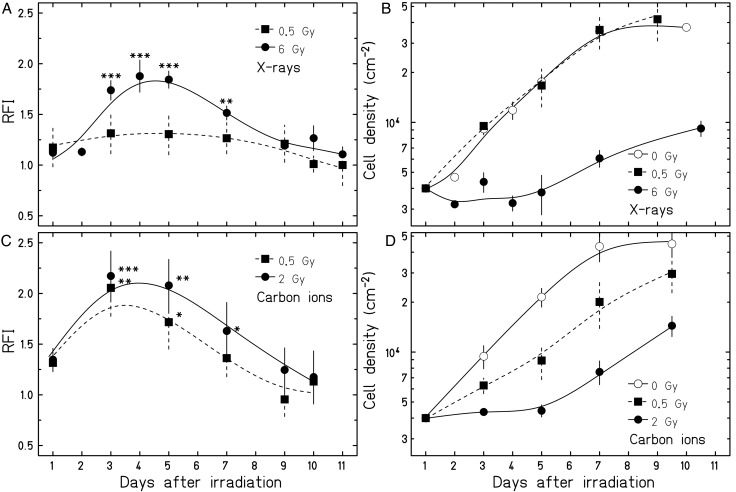
ROS levels and corresponding cell densities of AG1522 cells after X-ray (A, B; n = 3–8) or carbon ion irradiation (C, D; n = 3) as a function of the time after irradiation. Relative fluorescence intensities (RFIs) of DHE normalized to the mean of unirradiated cells (A, C) are shown. In (B) and (D) the corresponding cell densities are depicted. Significant difference of RFI from 0 Gy is indicated by a single asterisk (P < 0.05), two asterisks (P < 0.01) or three asterisks (P < 0.001). Note that the single experiments are averaged over the timepoints, resulting in error bars and significances that are different from Fig. 3 (see ‘Data analysis’ for details).